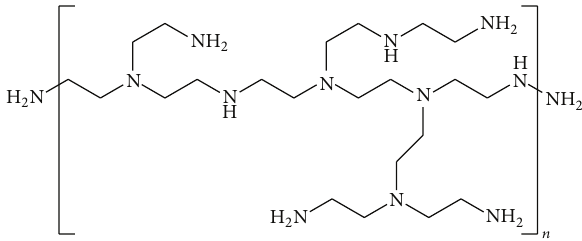
Figure 5: The chemical structure of polyethylenimine